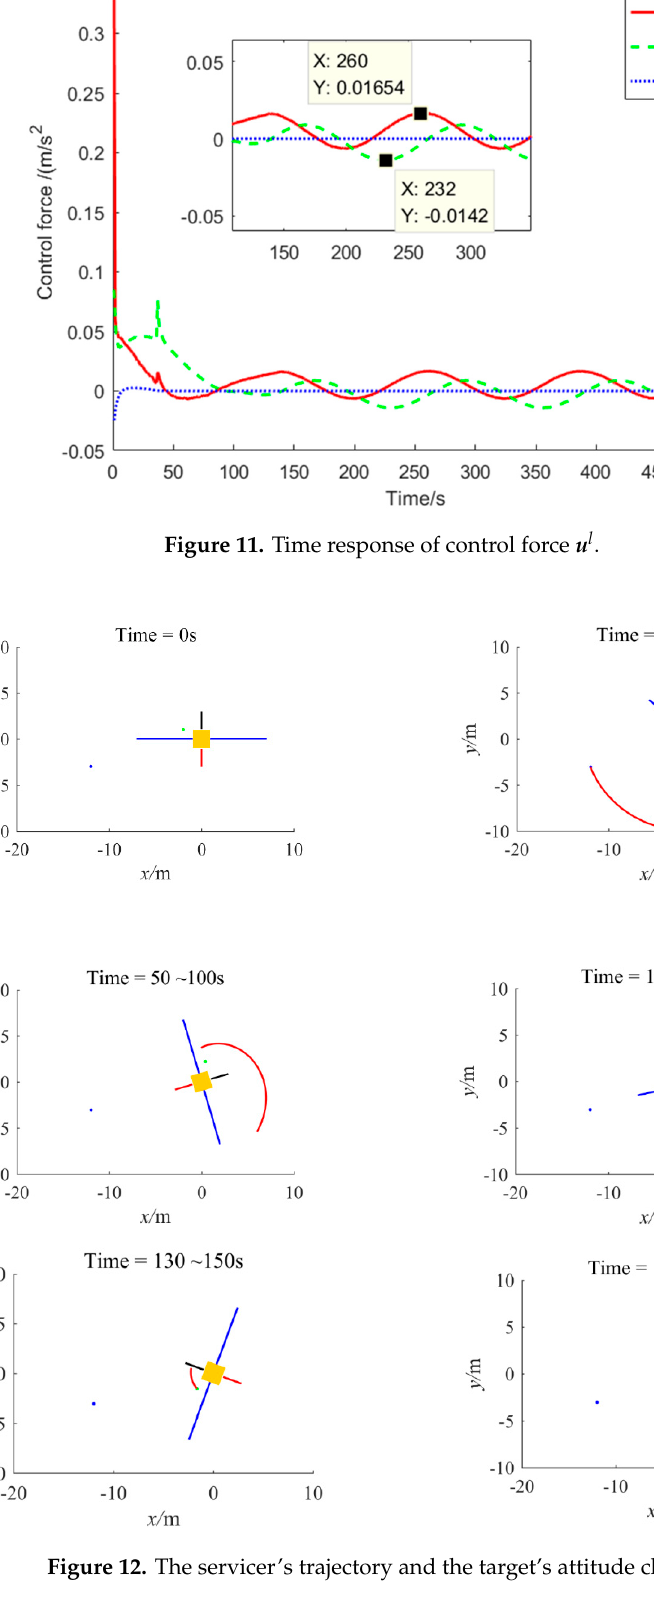
Figure 11. Time response of control force